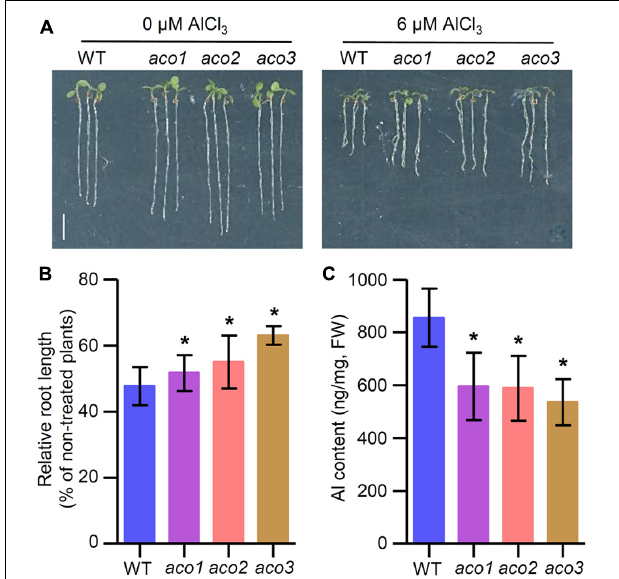
FIGURE 5 | Aconitases (ACOs) mediate the Al stress-induced inhibition of root growth. (A,B) Root growth of WT and aco mutant seedlings after a 7-day exposure to 0 or 6 µ M AlCl 3 . Three independent experiments were done, each with three replicates. Plants were grown at 22 ◦ C in long-day growth conditions. Scale bar, 0.5 cm. * p < 0.05 (Student’s t -test). (C) Al content in root of WT and aco mutants. * p < 0.05 (Student’s t